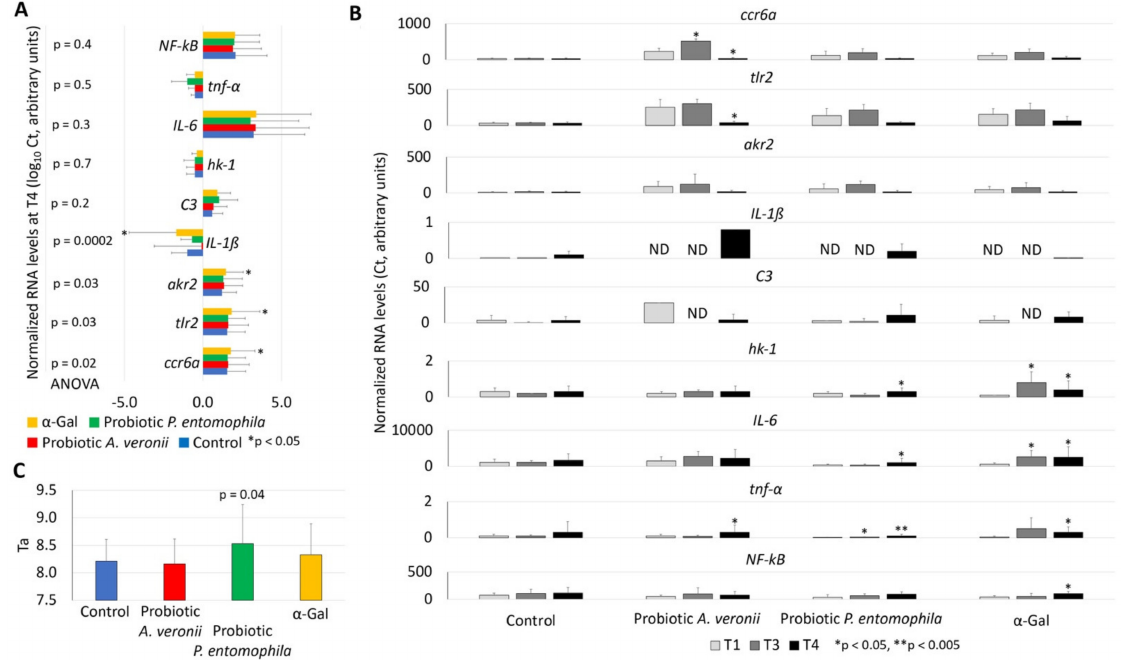
Figure 6. Expression of zebrafish immune-response genes in response to α -Gal and probiotic bacteria. The RT-qPCR was performed for the analysis of gene mRNA levels, using specific primers and conditions (Table 3). ( A ) The RNA normalized Ct values were compared between groups at T4 (end of the trial) by one-way ANOVA test followed by post hoc Holm multiple comparisons (https://astatsa.com/OneWay_Anova_with_TukeyHSD/; * p < 0.05, n = 3–20/group). ( B ) The RNA normalized Ct values were compared between T1 and T3/T4 by Student’s t -test with unequal variance (* p < 0.05, Materials Figure S1. ( C ) Antioxidant capacity in serum (Ta) was determined by using the potassium permanganate method and Ta values were compared between treated and control groups at T4 by Student’s t -test with unequal variance ( p < 0.05; n = 14–20/group). Data are shown as mean +